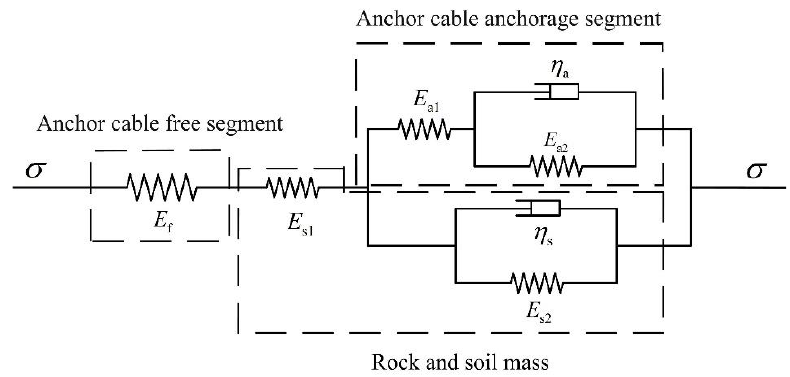
Figure 4. Schematic diagram of pile – anchor structure.